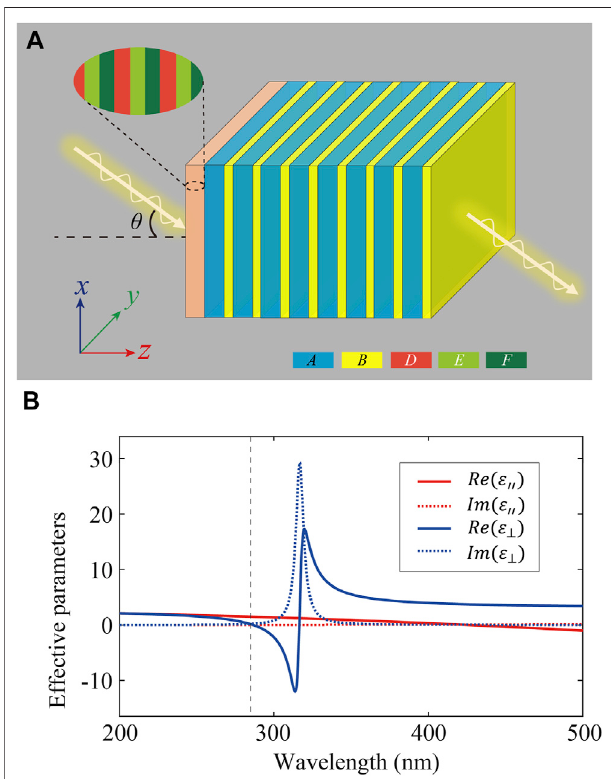
FIGURE 6 | (A) Schematic of the heterostructure composed of an effective magnetized anisotropic ENZ material layer ( DEF ) m and a truncated PC: ( AB ) n . D and F correspond to the SiO 2 layer with the thickness of 5 and 2 nm, respectively. E denotes the Ag layer with the thickness of 3 nm. The incident electromagnetic waves launch into the structure from the left at an incident angle θ . (B) Effective anisotropic electromagnetic parameters based on the SiO 2 /Ag/SiO 2 multilayer structure. ε // and ε ⊥ are marked by blue and red, respectively. The real part and imaginary part of the permittivity are shown by the solid line and dotted line, respectively. The magnetized anisotropic ENZ with negligible loss is marked by the black dashed line.